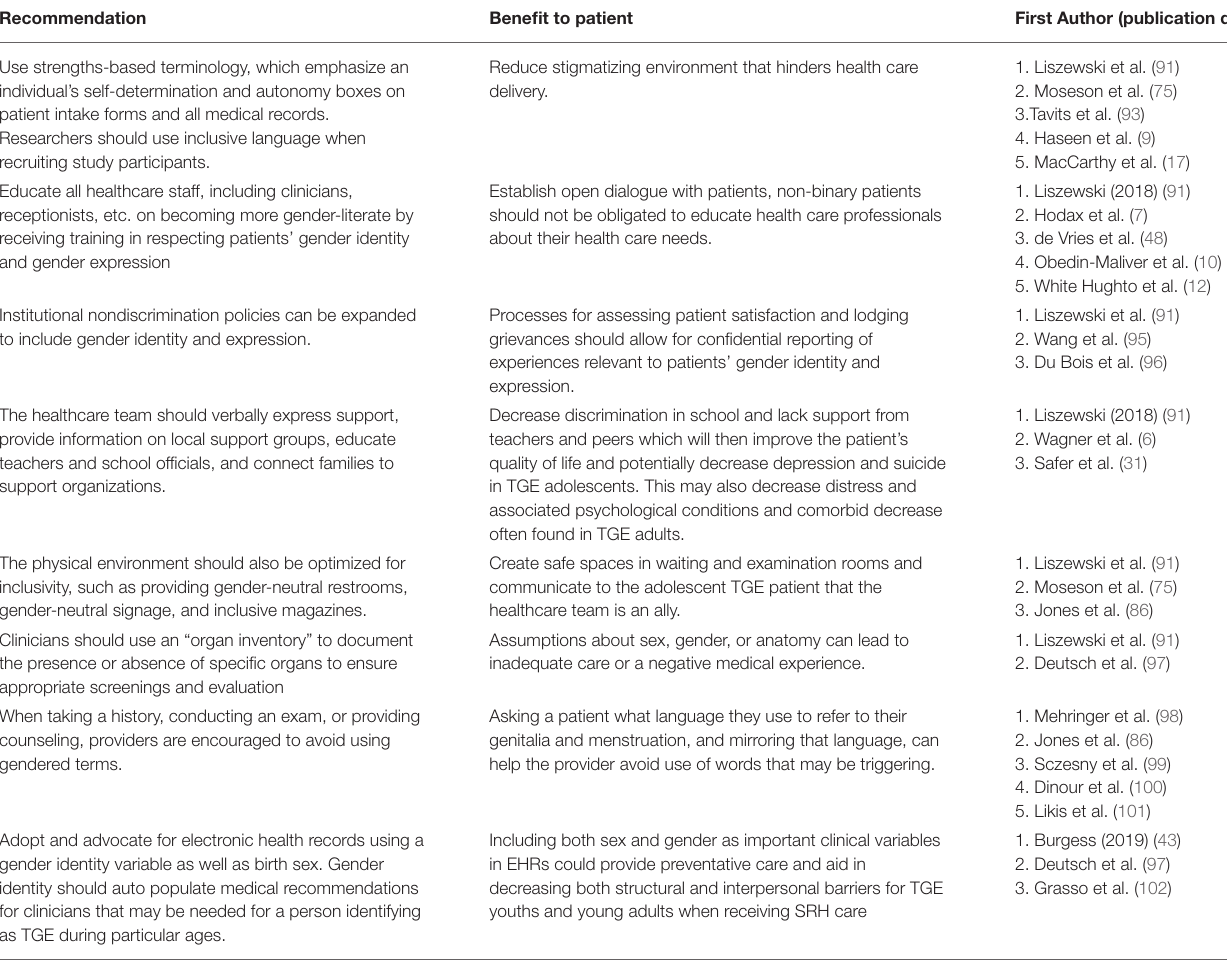
TABLE 2 | Suggestions for clinicians and researchers for providing care using the gender-affirming care model with the described patient benefit and source of recommendation.